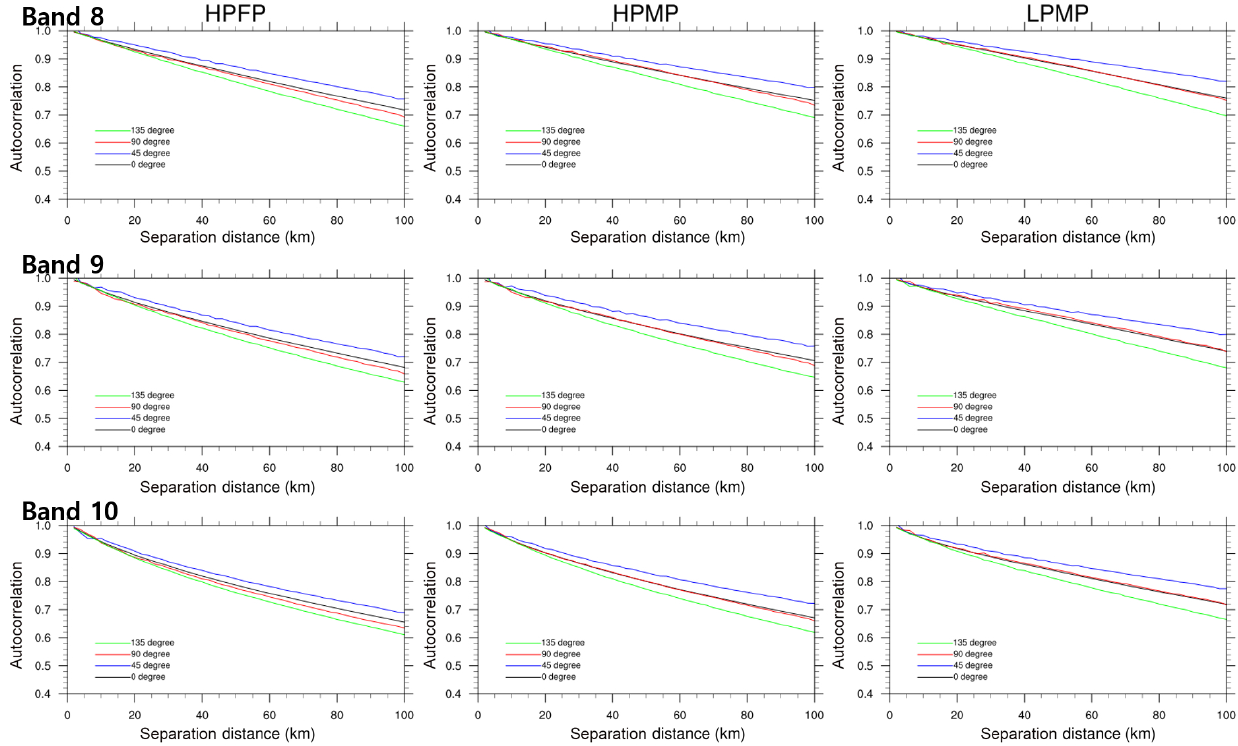
Figure 7. The averaged directional spatial autocorrelation of the brightness temperature of the AHI water vapor band 8, 9, and 10 by each precipitation type (i.e., HPFP, HPMP, and LPMP) for directions of 0 ◦ (black), 45 ◦ (blue), 90 ◦ (red), and 135 ◦ (green). The direction (angle) is measured counterclockwise from the origin–east axis (i.e., 0 ◦ ).